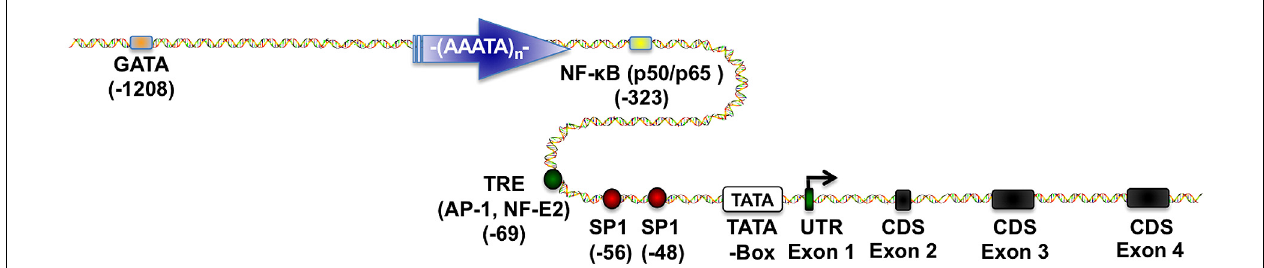
the cellular environment (Borde-Chiche etal., 2001b; Duvoix etal., 2003a,b, 2004a,b), (iii) one nuclear factor kappa-light-chain-enhancer of activated B cells (NF- κ B) binding site (Morceau etal., 2004), and (iv) a GATA-1 binding site (Schnekenburger etal., 2003, 2004). Figure was generated by using